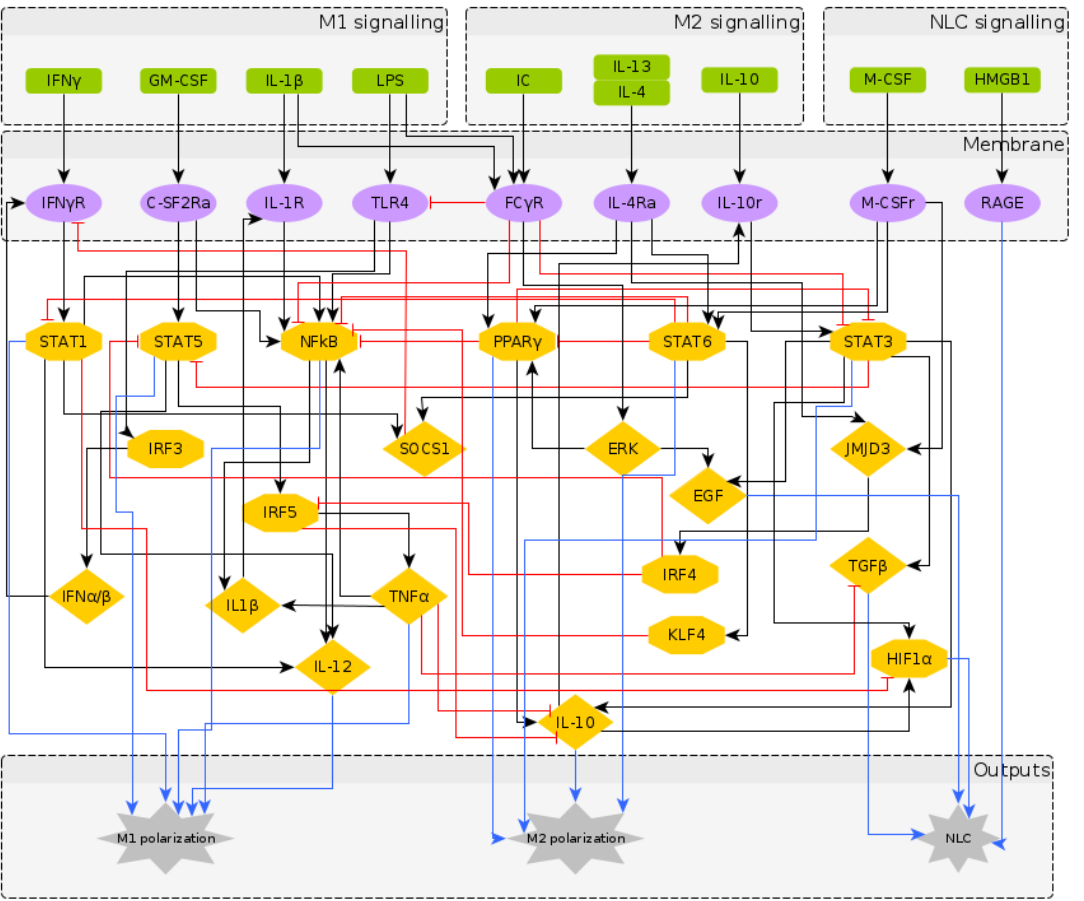
Figure 1. The regulatory network of macrophage polarization: Nodes in green represent the extra-cellular signals, classified as M1, M2 and NLC inducers; nodes in purple represent receptors in the macrophage membrane, usually activated upon contact with cells in the outer environment; nodes in yellow represent the transcription factors and chemokines involved in the polarization process, as an intermediate step or as an output. The diamond nodes represent cytokines whereas the hexagonal nodes represent transcription factors. The interactions between components can be either activation (black) or inhibition (red), while the blue arrows represent the markers for each polarization